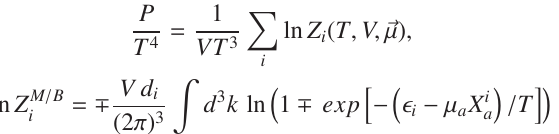
Figure 1. ALICE PbPb √ s NN = 5 . 02 GeV data for particle yields in 0 to HRG model calculations with di ff erent resonance lists; deviations in units of experimental errors σ are shown below each